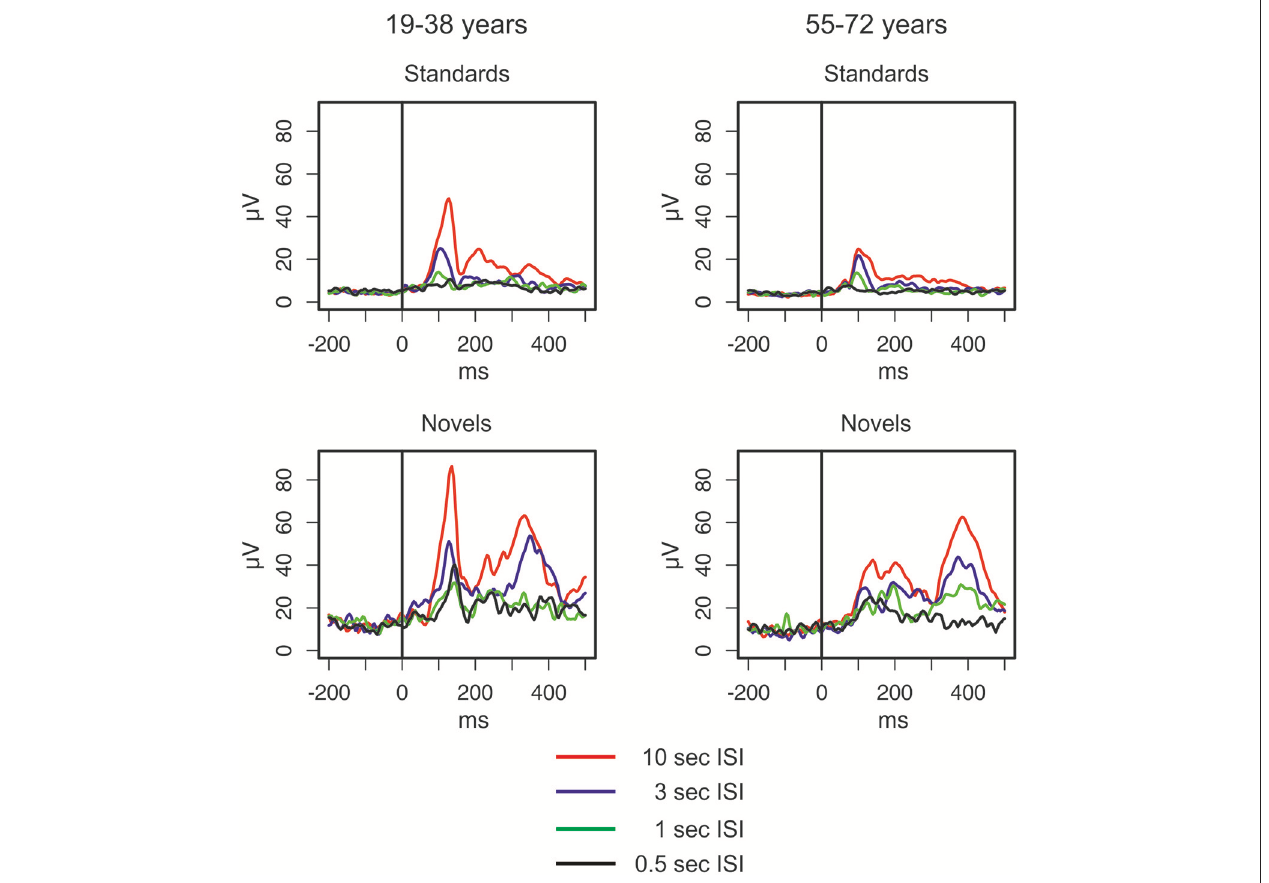
FIGURE 2 | Global field power elicited by standard and novel auditory stimuli separated for the two groups of participants and the four different ISI conditions (for details see main text).